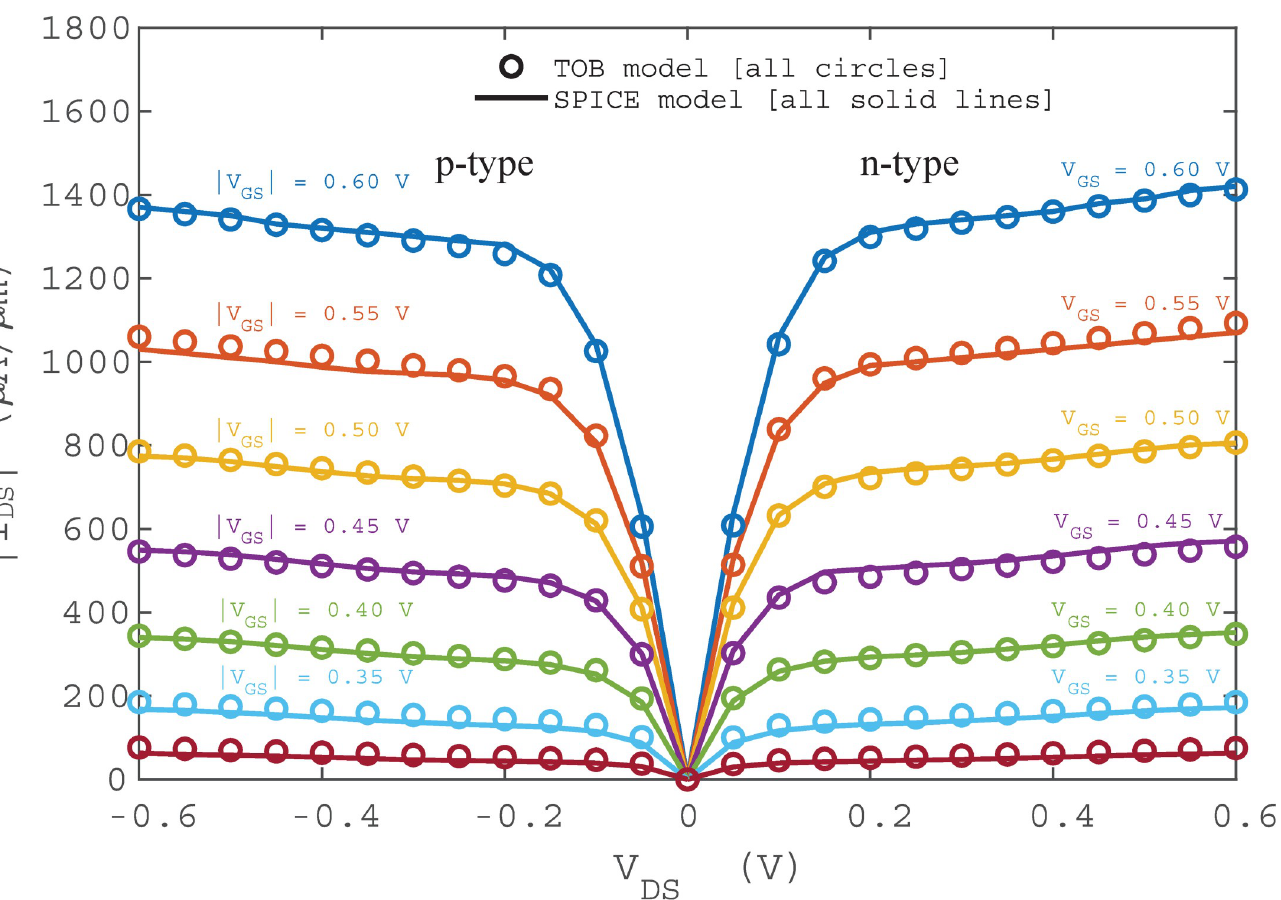
Fig 4. Comparison of I-V characteristics between iterative and non-iterative TOB nanotransistor models.